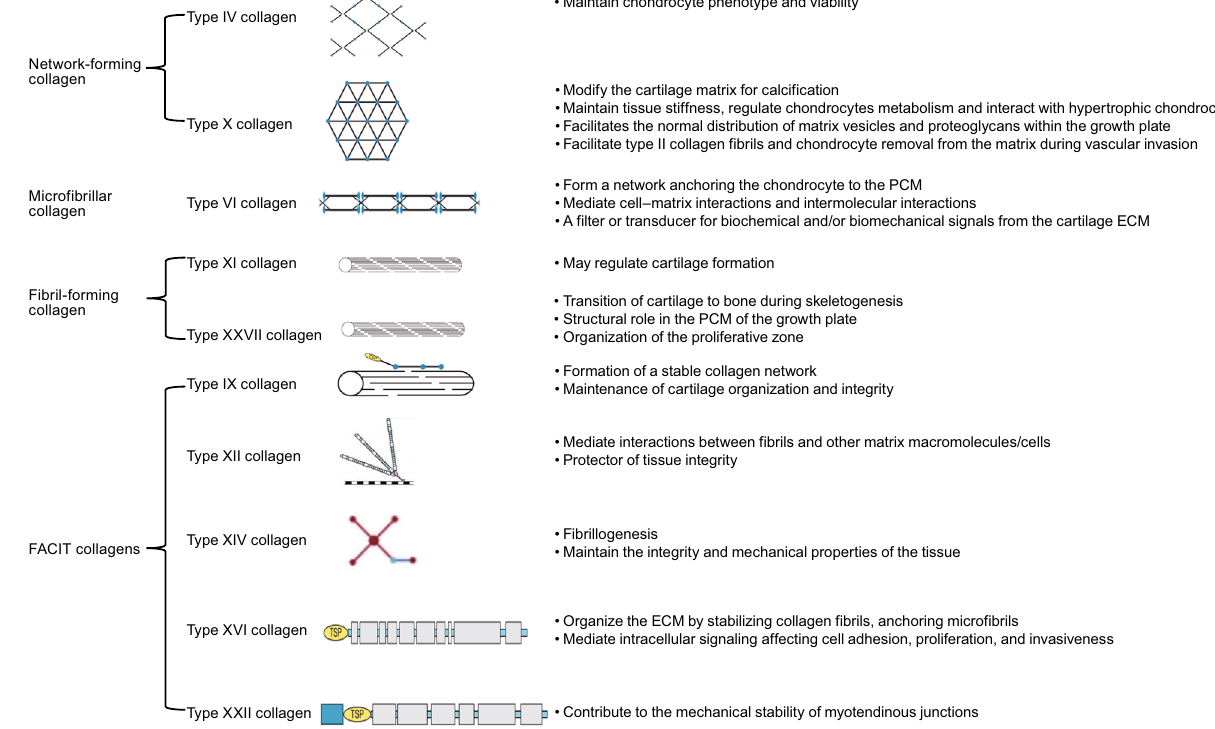
Figure 1. The schematic of minor collagens in articular cartilage. Reproduced with permission from Richard-Blum, S. The collagen family. Cold Spring Harb Perspect Biol 2011;3:a004978. PCM: pericellular matrix; ECM: extracellular